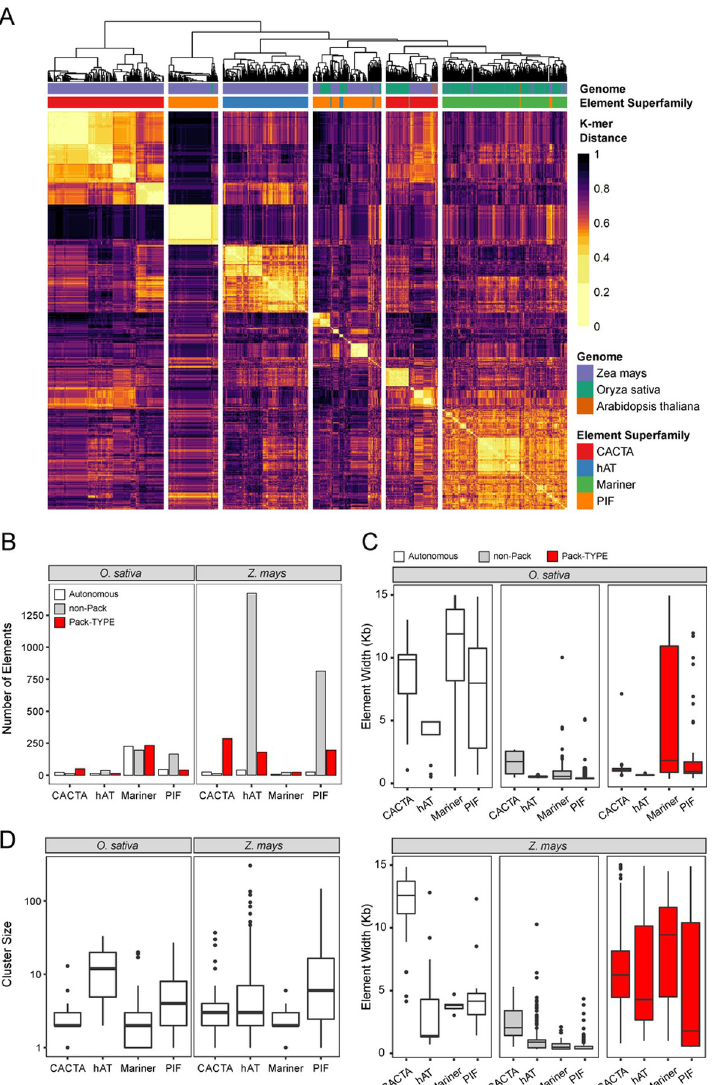
Fig 2. The DNA sequence properties of Pack-TYPE TEs in Oryza sativa and Zea mays . A Visualisation of the symmetric distance matrix for the forward TIRs of all annotated Pack-TYPE TEs. Distance was calculated using the alignment-free kmer algorithm, and elements are ordered by hierarchical clustering (see Methods ). The dendrogram was cut such that six groups were identified, separated by vertical whitespace. B Bar plot displaying the total number of elements annotated by packFinder in each of the TIR superfamilies tested in both rice ( O . sativa ) and maize ( Z . mays ) genomes. Colours represent TE functional designation, assigned automatically using BLAST. C Box plots displaying the distribution of TE widths in each category, defined after applying the packFinder BLAST step in both the rice ( O . sativa ) and maize ( Z . mays ) genomes. D Boxplots for the distribution of annotated cluster sizes in both rice ( O . sativa ) and maize ( Z . mays )